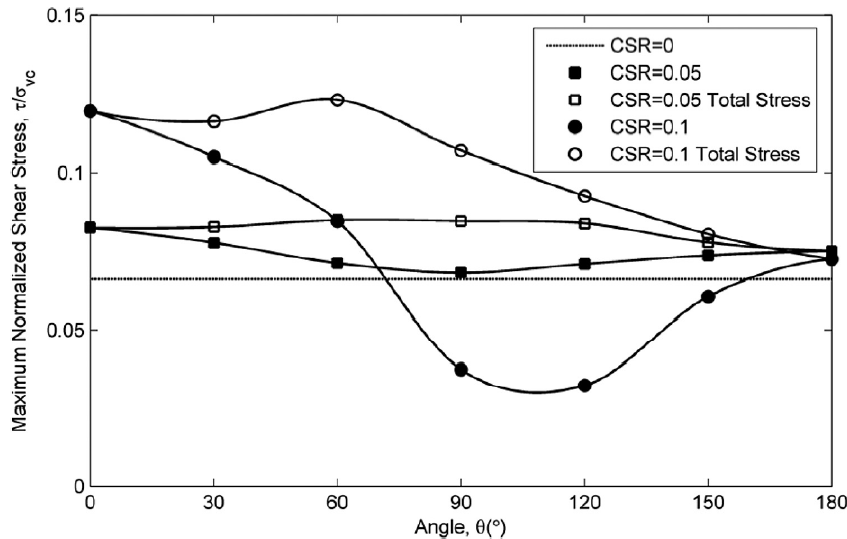
Figure 12. Shear strength along the x ‐ direction and the total shear strength for the different angles of shear consolidation under the consolidation shear stress ratio (CSRs) of 0.05 and 0.1 [52].